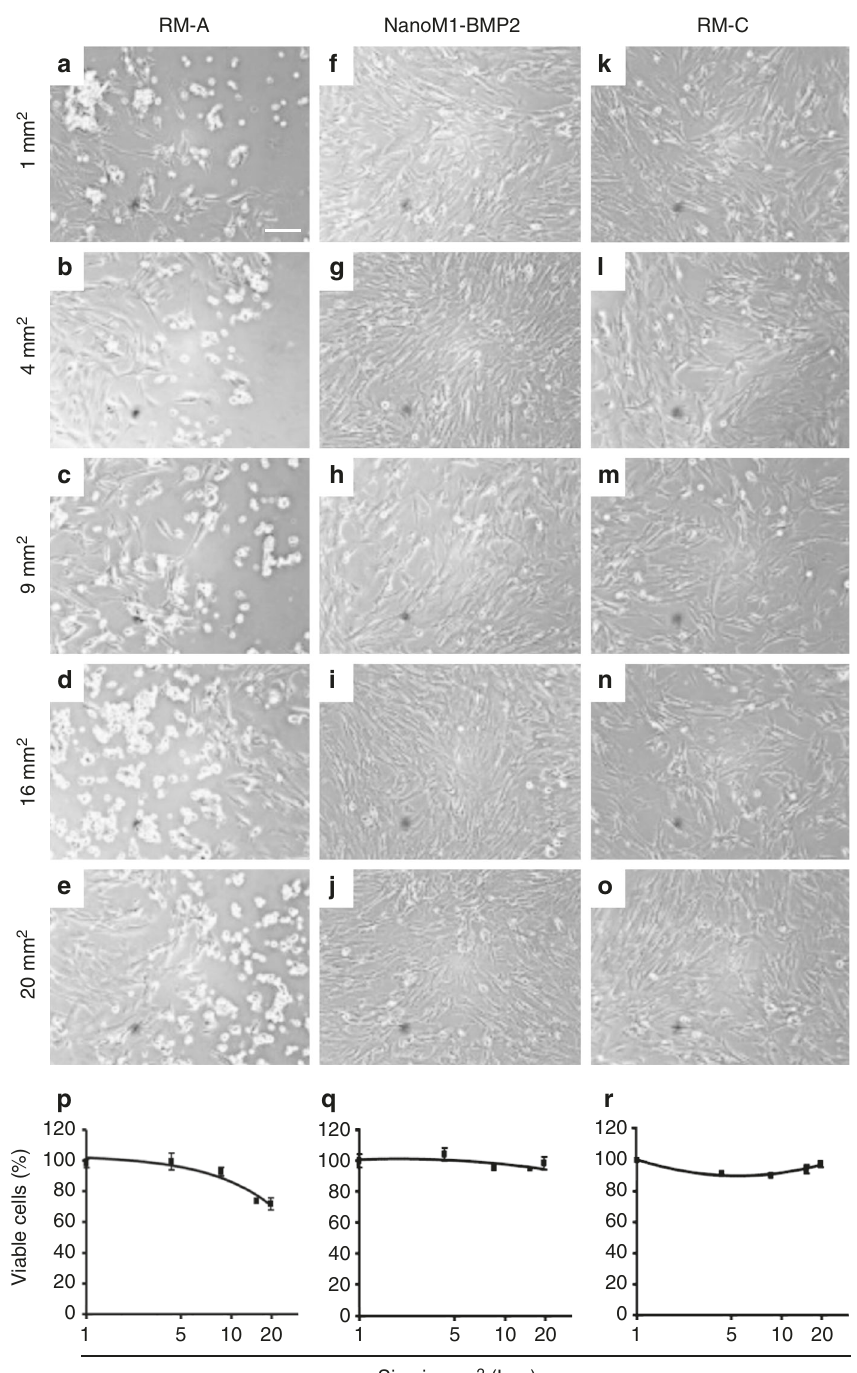
Fig. 2 In vitro evaluation of the NanoM1-BMP2 wound dressing cytotoxicity. MRC-5 cell line was cultured in the presence of Polyurethane fi lm, (RM-A; a – e ), NanoM1-BMP2 wound dressing ( f – j ) or high density polyethylene fi lm (RM-C; k – q ). Five sizes (20, 16, 9, 4, 1 mm²) of membranes were used. Cells were inspected for morphological changes over a 3 day period. Proliferation/viability was assessed via WST-1 assay ( p – n ) at 24 h (C.Ris Pharma, CRO, France). Error bars represent standard deviation. Scale bar: 100 µ